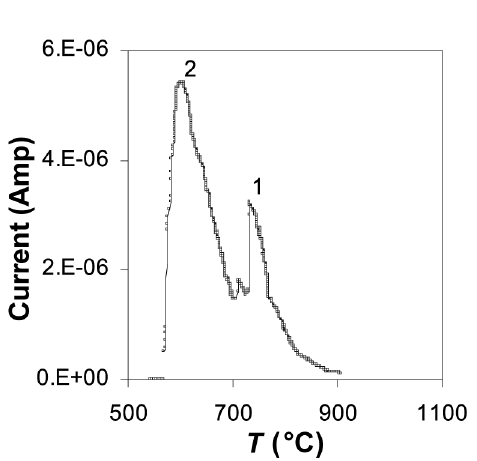
Fig. 1. Release spectrum of helium from basaltic glasses heated at a rate of 10°C/min. Data from Paonita et al . (2000). Peak 2 provides the amount of dissolved gas, whereas peak 1 has been attributed to the decrepitation of fluid